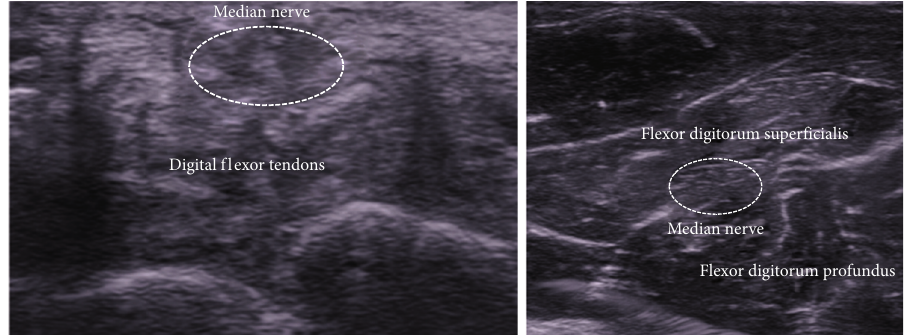
Figure 6: The median nerve depicted as a fascicular pattern can be identified on the superficial layer of the flexor tendons at the wrist joint level. Identifying the median nerve at the wrist level and then moving the probe to the forearm makes it easier to identify the median nerve between the flexor digitorum superficialis and flexor digitorum profundus. (a) Wrist. (b) Middle part of the forearm.